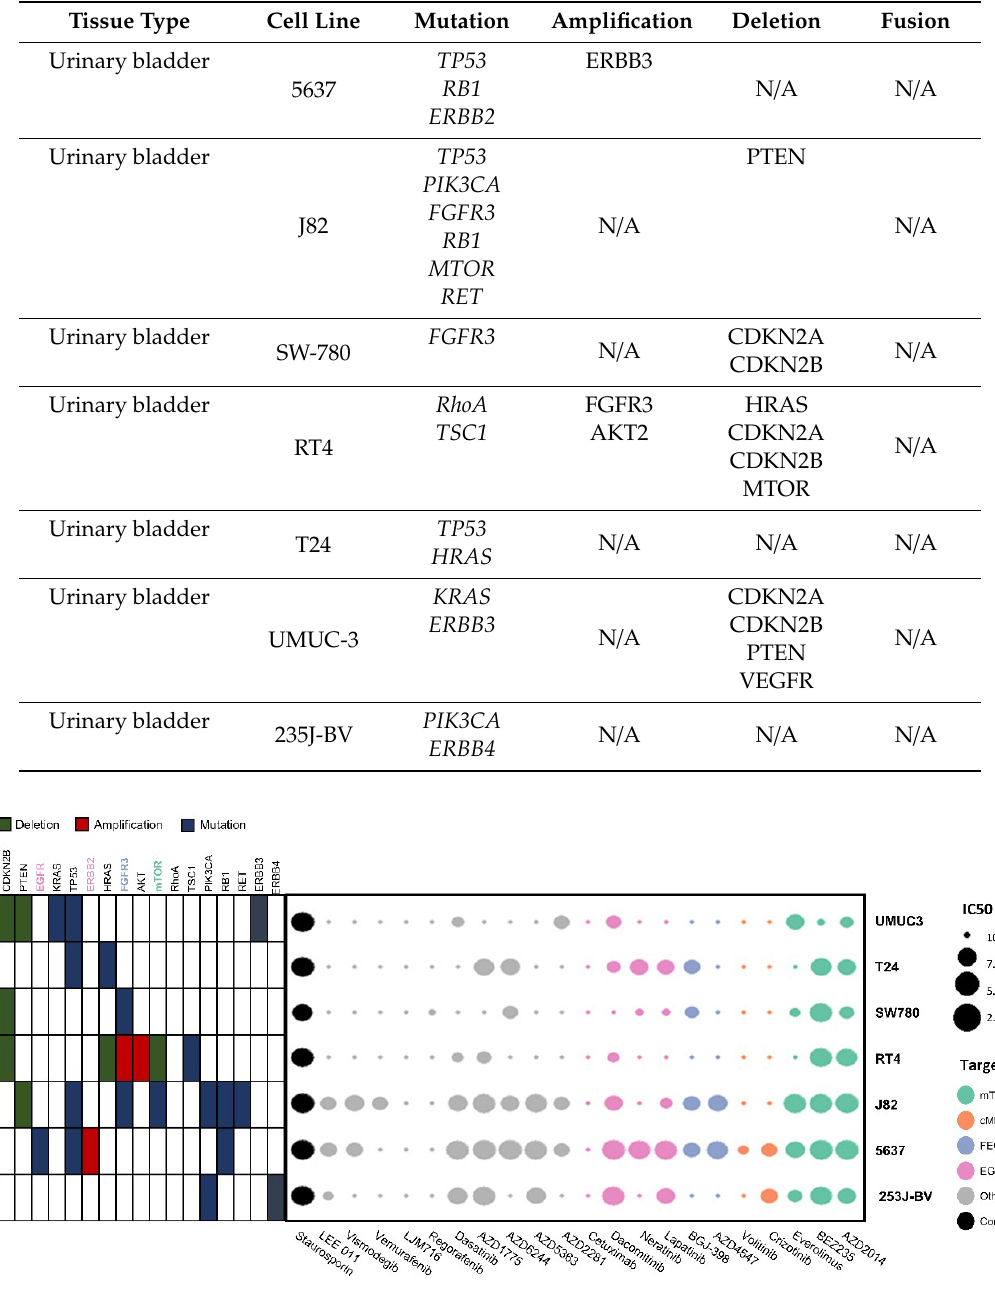
Table 1. Molecular characteristics of seven bladder cancer cell lines.